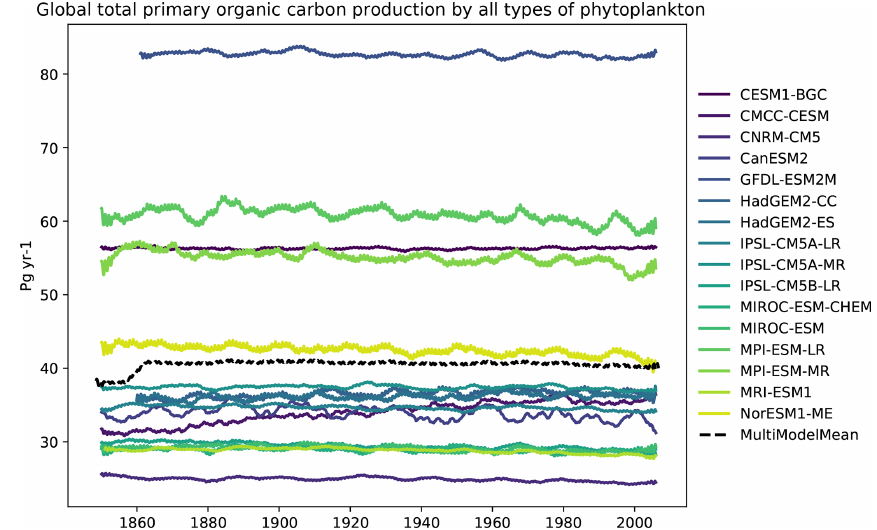
Figure 25. The global total integrated primary production from phytoplankton for a range of CMIP5 models in the historical experiment in the r1i1p1 ensemble member, with a 6-year moving average smoothing function. The multi-model mean is shown as a dashed line. Produced with recipe_ocean_scalar_fields.yml described in Sect. 3.3.1.